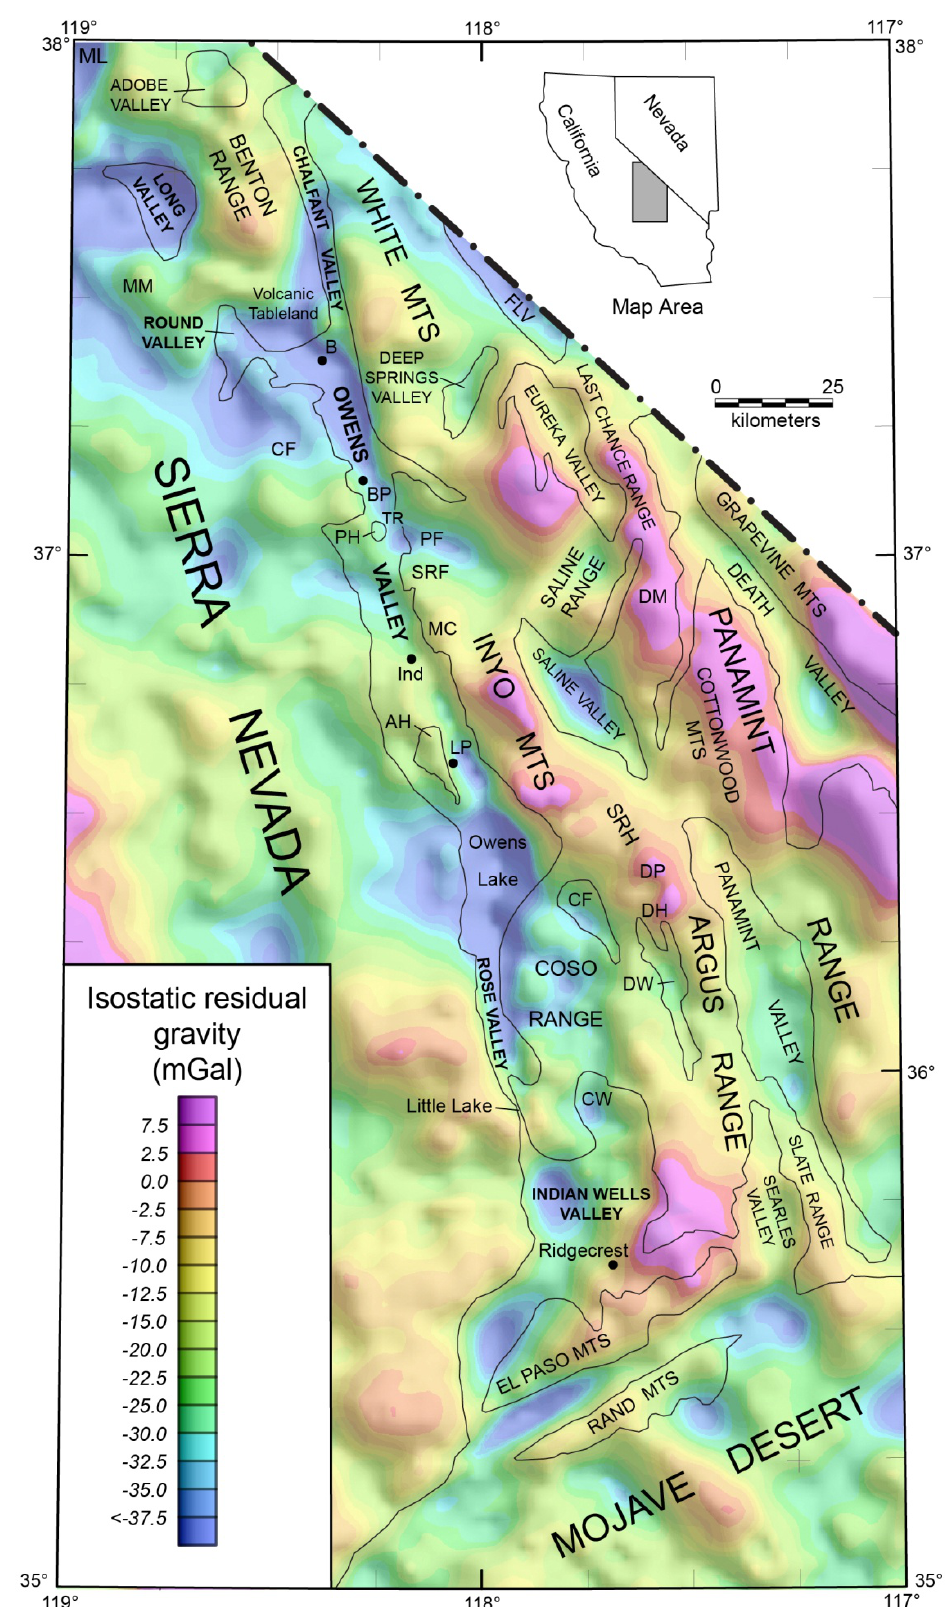
Figure 4. Isostatic gravity map of east-central California [53]. Shading of the gravity highs and lows simulates a shaded relief map of topography with lighting from the northeast. For abbreviations see caption for Figure